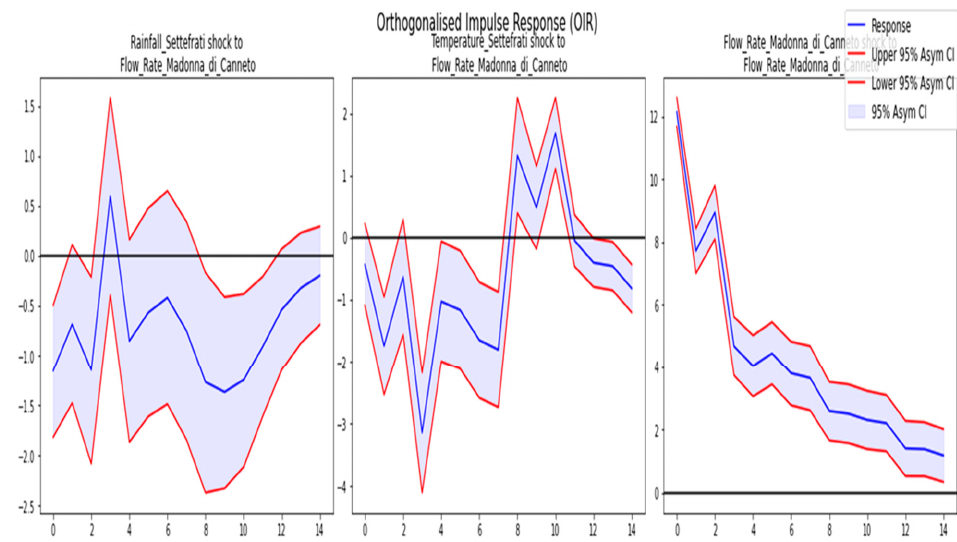
Figure 10. OIR plot for Flow_Rate (Water Springs-Madonna_di_Canneto).